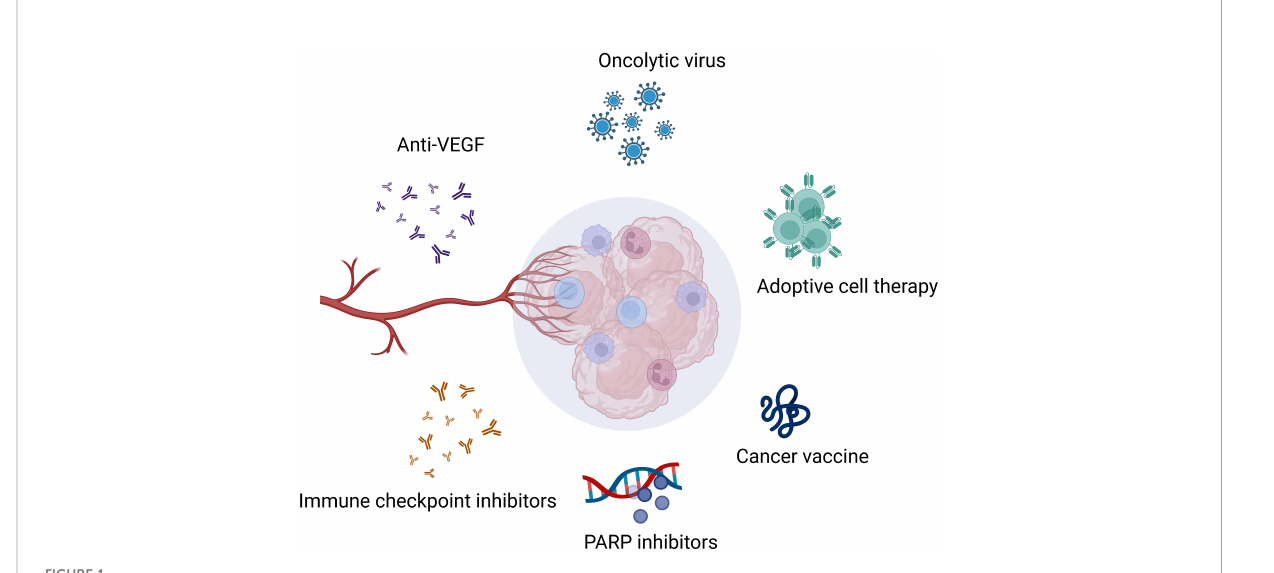
FIGURE 1 Immunotherapies in ovarian cancer. Created with